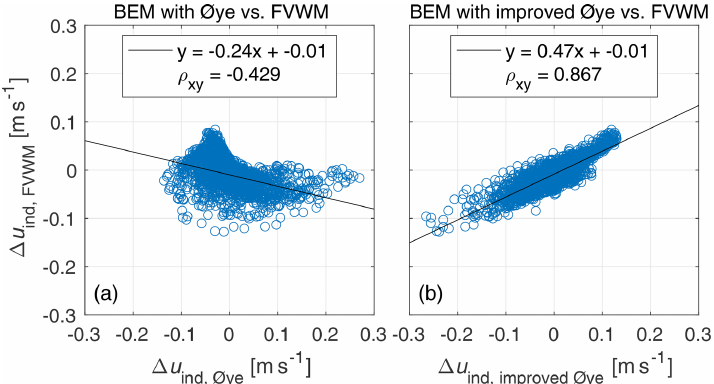
Figure A3. Scatter plot with correlation coefficients of the differences in u ind between the (quasi-)steady and dynamic cases of the stochastic gust at 0.6 R . Comparison of FVWM and Øye in panel (a) and FVWM and improved Øye in panel (b)